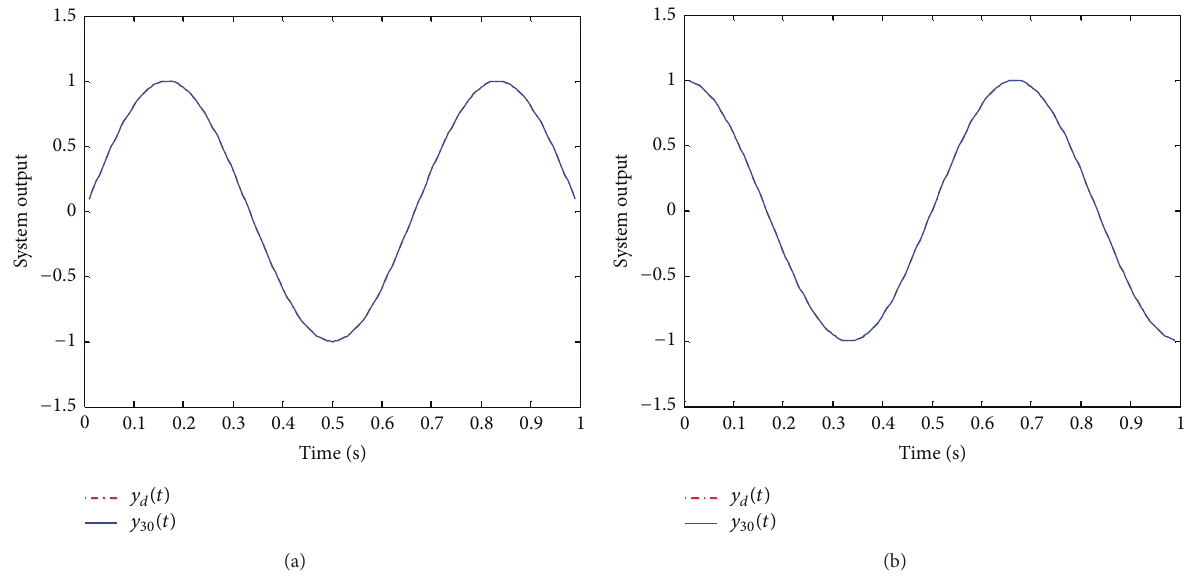
Figure 9: System output trajectory at 30th iteration for Example 2: (a) 𝑦 1,𝑘 (𝑡) , (b) 𝑦 2,𝑘 (𝑡) .